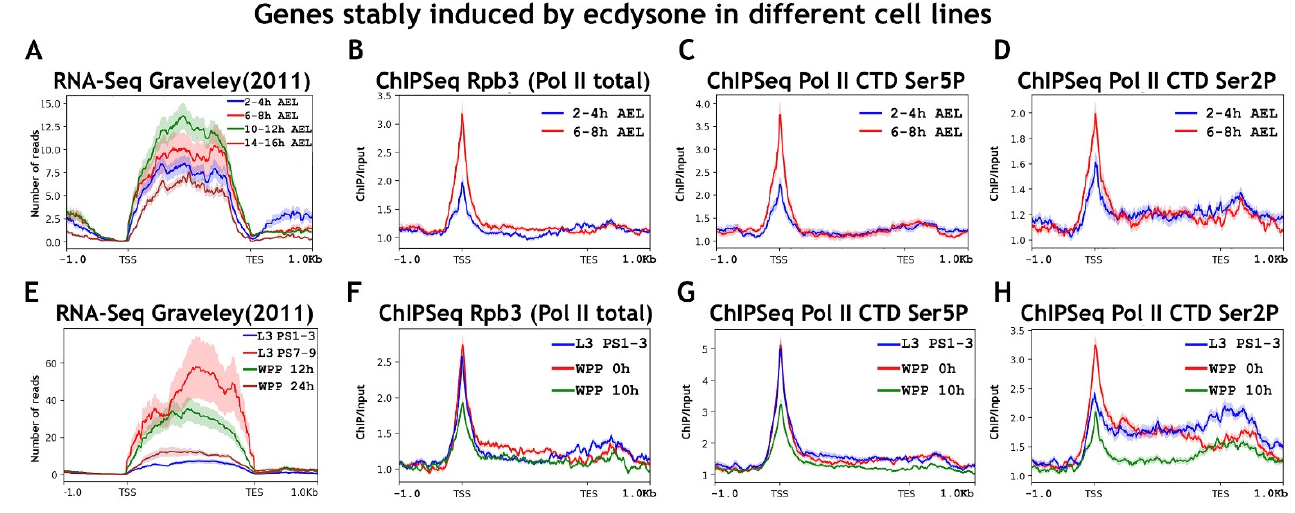
Figure 7. Average binding profiles of various Pol II isoforms on genes induced by ecdysone during Drosophila embryogenesis and metamorphosis average of the ( A , E ) RNA-seq signal and an average distribution of ( B , F ) Rpb3 (Pol II subunit); ( C , G ) Pol II Ser5P CTD; and ( D , H ) Pol II Ser2P CTD binding across the genes induced by 20-hydroxyecdysone (ecdysone) at various stages of Drosophila development (total 68 genes/236 transcripts). A pool of ecdysone-induced genes was selected using previously published data on the ecdysone response of various Drosophila cell lines [55]. ChIP-Seqs were performed on whole embryos of 2–4 h (blue line at ( A – D )) and 6–8 h (red line at ( A – D ) after eggs laying (AEL); on whole larvae of L3 PS1-3 full gut stage (blue line on ( E – H )), prepupae 0 h after puparium formation (WPP, red line on ( E – H )) and prepupae 10 h after puparium formation (WPP 10 h, green line on ( E – H )). Protein binding levels were calculated as an enrichment (ratio of the corresponding ChIP-Seq signal to the input DNA). Average profiles were generated using the metagene mode (introns were ignored and gene bodies were scaled to 2 kb) and calculated as the mean of the protein binding signal. The standard error appears on the graphs as a lighter area around